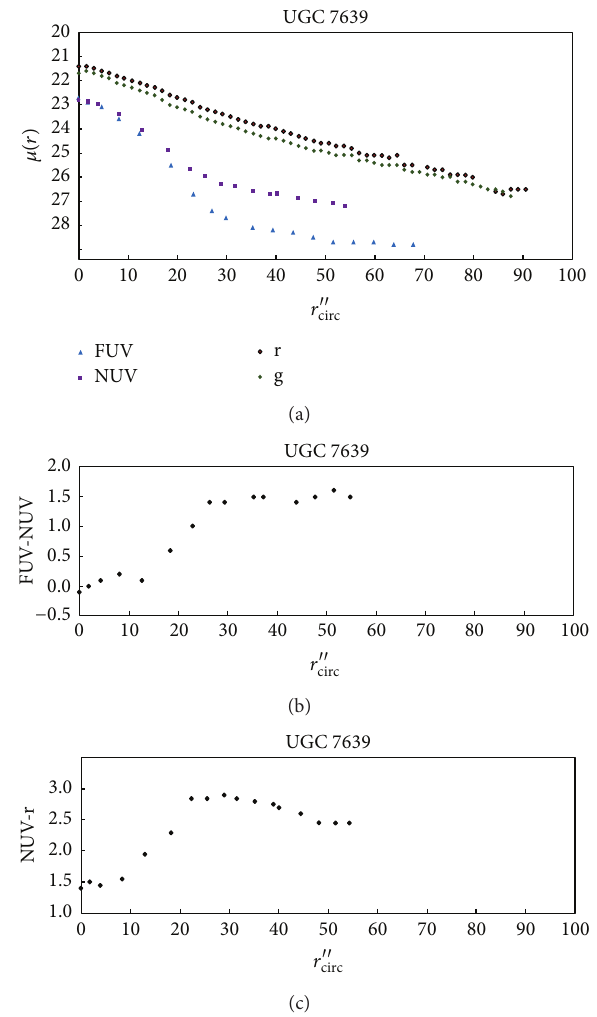
Figure 2: (a) GALEX NUV and FUV and optical r- and g-band surface brightness profiles of UGC 7639 (magenta squares, cyan triangles, and red and green circles, resp.) versus circularized radius. (b) (FUV-NUV) color profile. (c) UV/optical (NUV-r) color profile. Since BCDs experience mostly off-centered star formation (cf. [18]), these profiles could be affected by the difficult identification of the main stellar body centre.